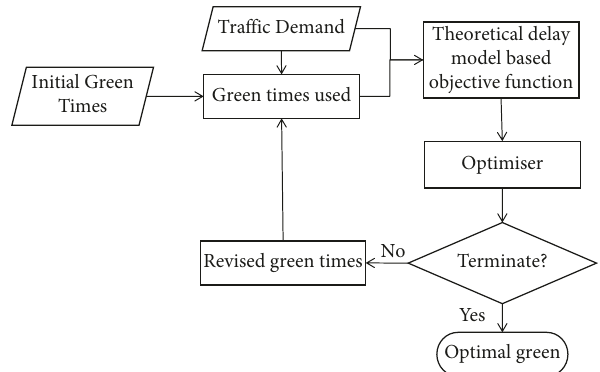
Figure 11: Methodology for obtaining optimal signal 6.1. Optimal Green Time Calculation. To obtain the optimal green timings, which minimises the average intersection control delay, the methodology shown in Figure 11 is used.